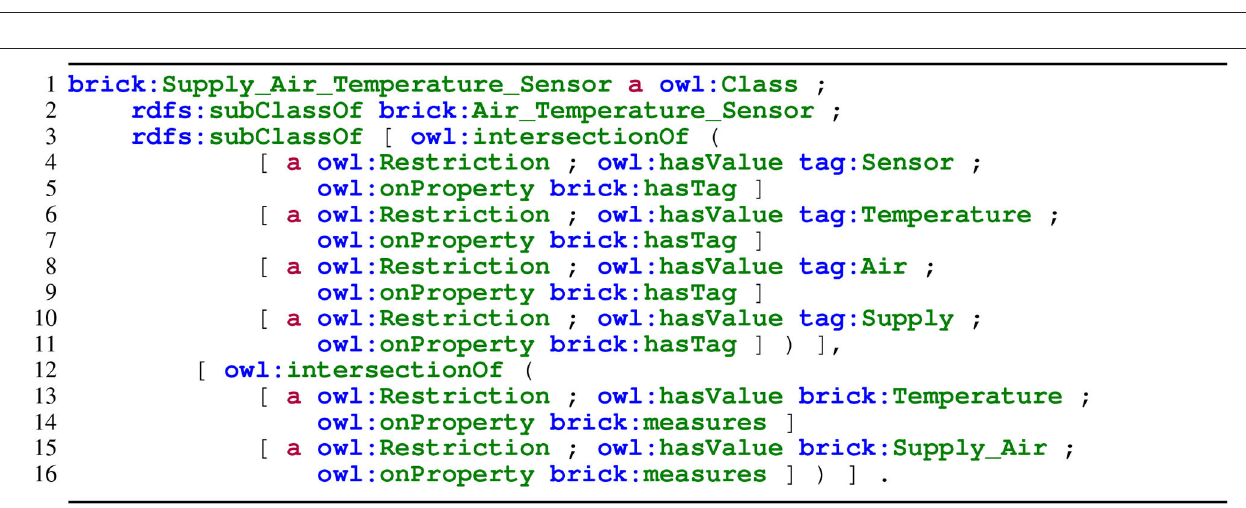
FIGURE 3 | OWL DL-compatible definition of the Brick Supply Air Temperature Sensor class showing the explicit class structure, tag equivalence, and the use of substance and quantity classes to model behavior.